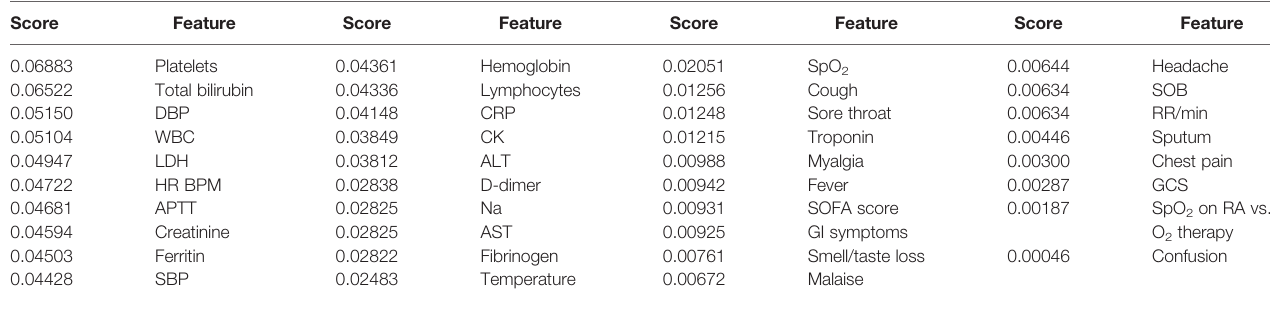
TABLE 5 | Ranking scores of variables selected for ML